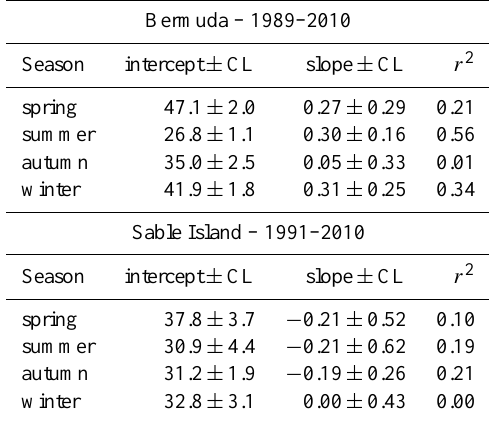
Table 4. Parameters of linear regression using least-squares fits to the Sable Island and Bermuda data sets for the indicated time peri- ods. CL indicates the 95% confidence limits of the respective pa- rameters, and r is linear correlation coefficient. Units are ppbv and ppbvyr − 1